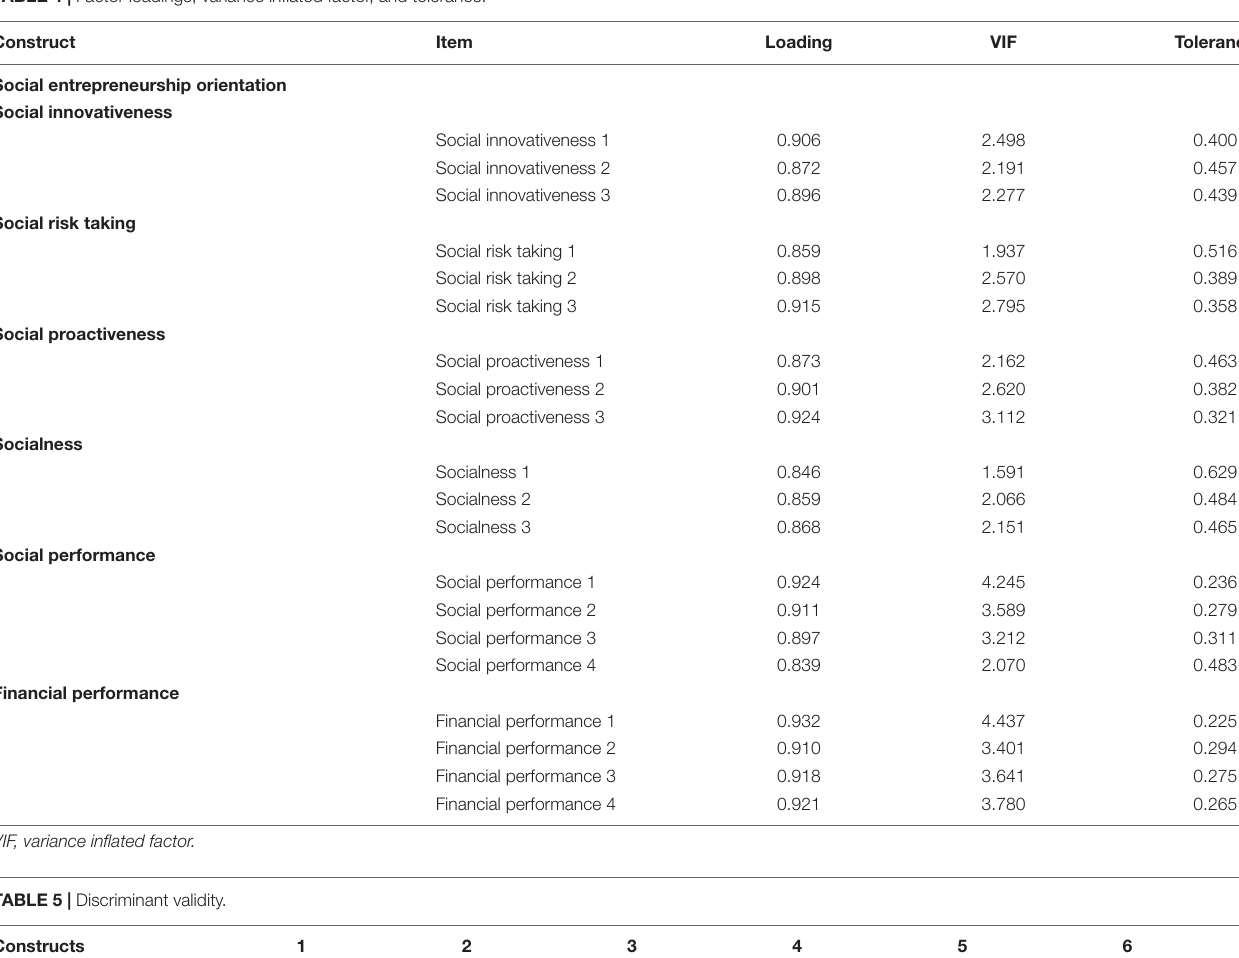
TABLE 4 | Factor loadings, variance inflated factor, and tolerance.